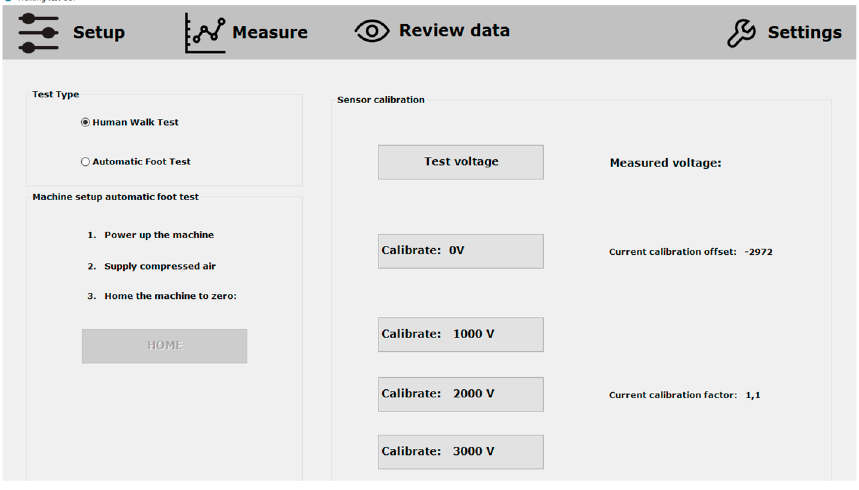
Figure 6. Graphical user interface for the automated tester.